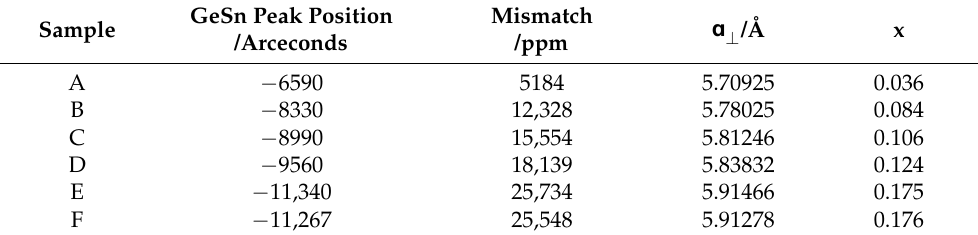
Table 3. Sn content in GeSn layers obtained from HRRLMs.